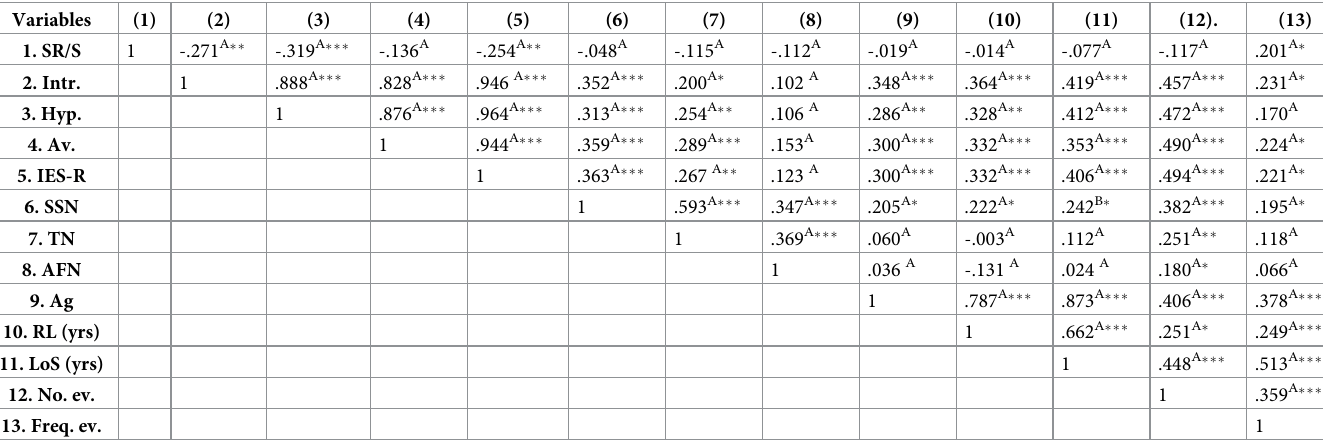
Table 4. Correlations between PTSD symptomatology, male role norms, social support and sociodemographic data.